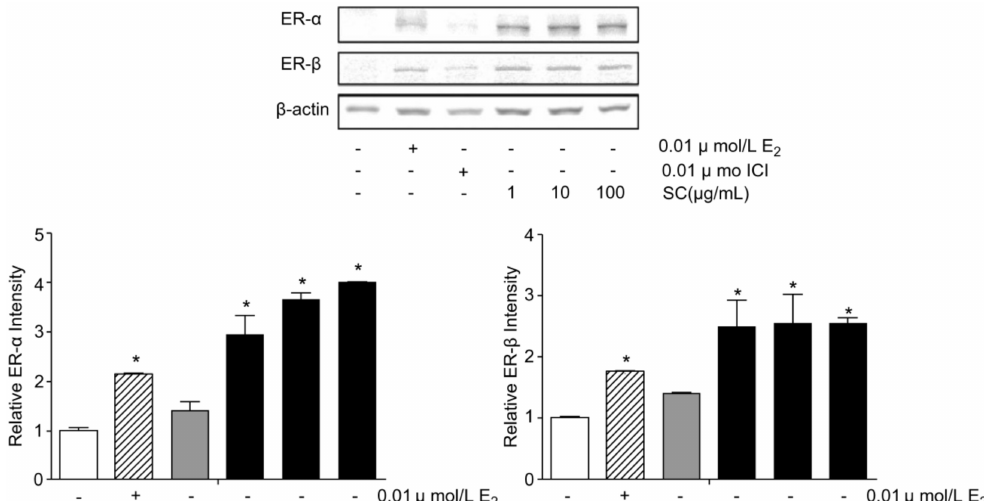
Figure 11. Expressions of ER α and ER β levels by Schisandra chinensis extract treatment in MCF − 7 cells. * p < 0.05, compared with normal group. Reprinted from Kim, M.H.; Lee, H.S.; Hong, S.B.; Yang, W.M. Schizandra chinensis Exhibits Phytoestrogenic Effects by Regulating the Activation of Estrogen Receptor- α and - β . Chin. J. Integr. Med. 2017 , 1–5, with permission. © 2017, Springer Nature